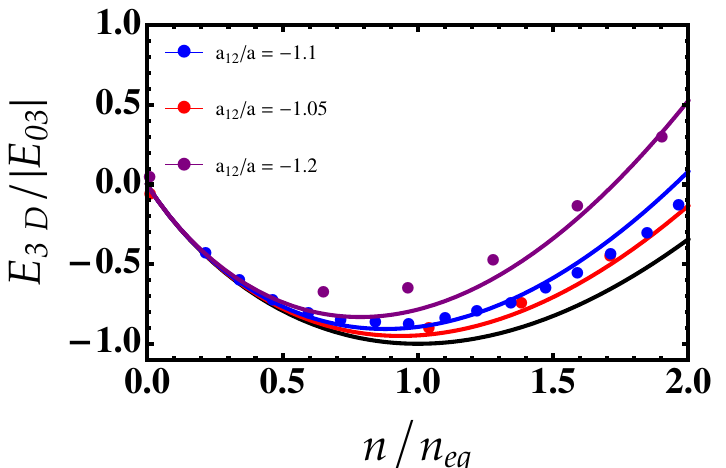
Figure 1. (Color online) Three-dimensional ground-state energy from (11) as a function of n / n eq for different values of a 12 / a . Color solid lines correspond to our results up to second-order corrections of quantum fluctuations. Black line correspond to the results of ref. [20] . Color dots represent the QMC results of ref. [37].